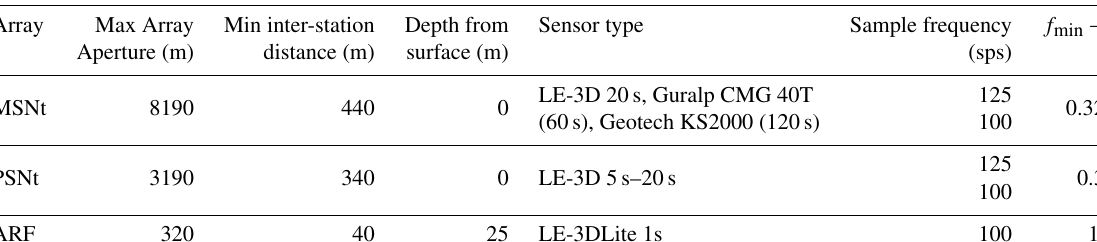
Table 1. Geometry and technical characteristics of the three arrays.